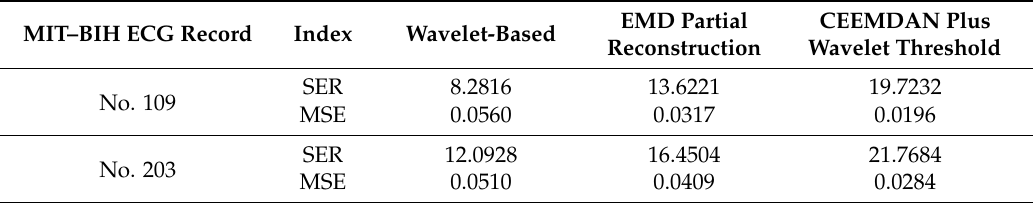
Figure 9. No. 203 MIT–BIH ECG signal de-noising results. Table 5. Real ECG signal de-noising performance indices